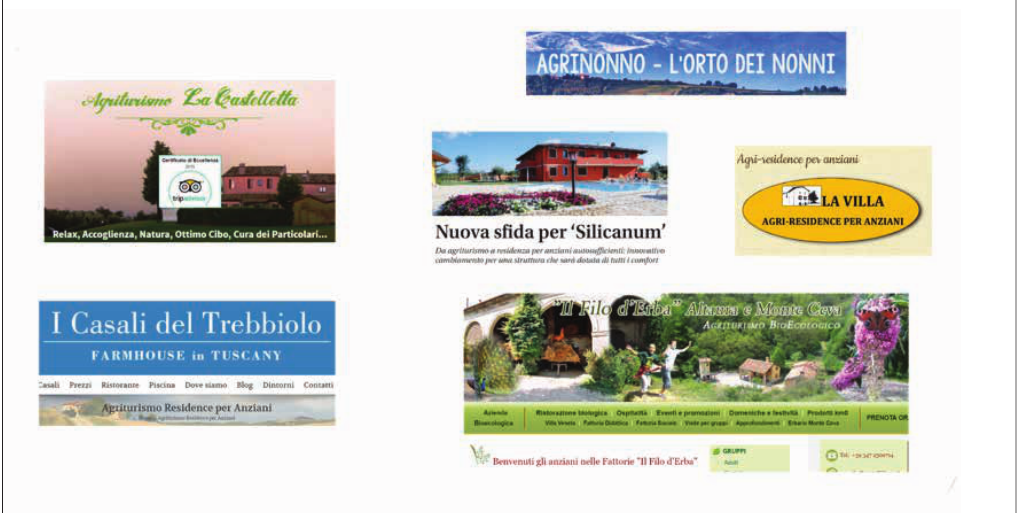
Figure 1: The main farmhouses with elderly-dedicated activities investigated in Italy (Source: our